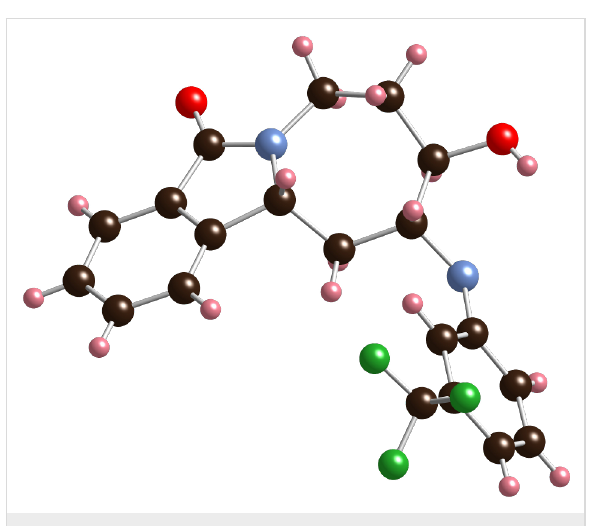
Figure 6: X-ray structure of amino alcohol 10{ 7 }